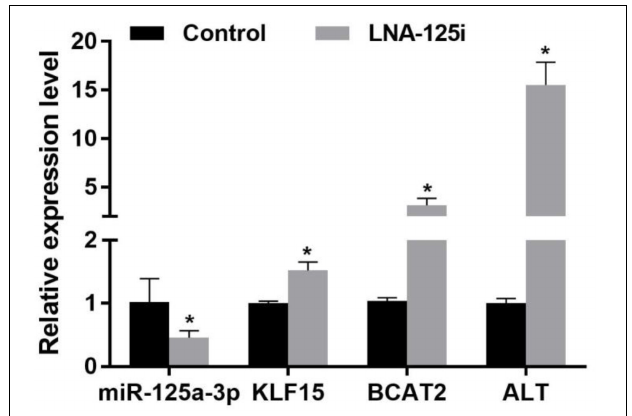
FIGURE 4 | Effect of the expression of the miR-125a-3p-KLF15-BCAA- related gene mRNA level in the skeletal muscle of Nile tilapia after injection with LNA-125i. Values represent the mean ± SE ( n = 9 fish, 3 fish were sampled for each tank). * p < 0.05 significantly different vs. control. BCAA, branched-chain amino acid.